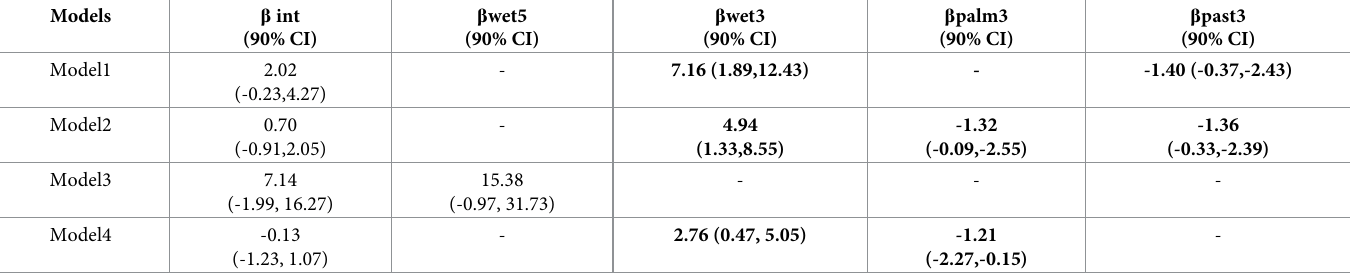
Table 4. Results of the top models. Parameter estimates and 90% credible intervals (CI) influencing jaguar habitat use in the middle Magdalena River valley, Colombia. Covariates were considered to have a significant influence on jaguar habitat use when their 90% CI did not overlap zero (marked in bold). Models